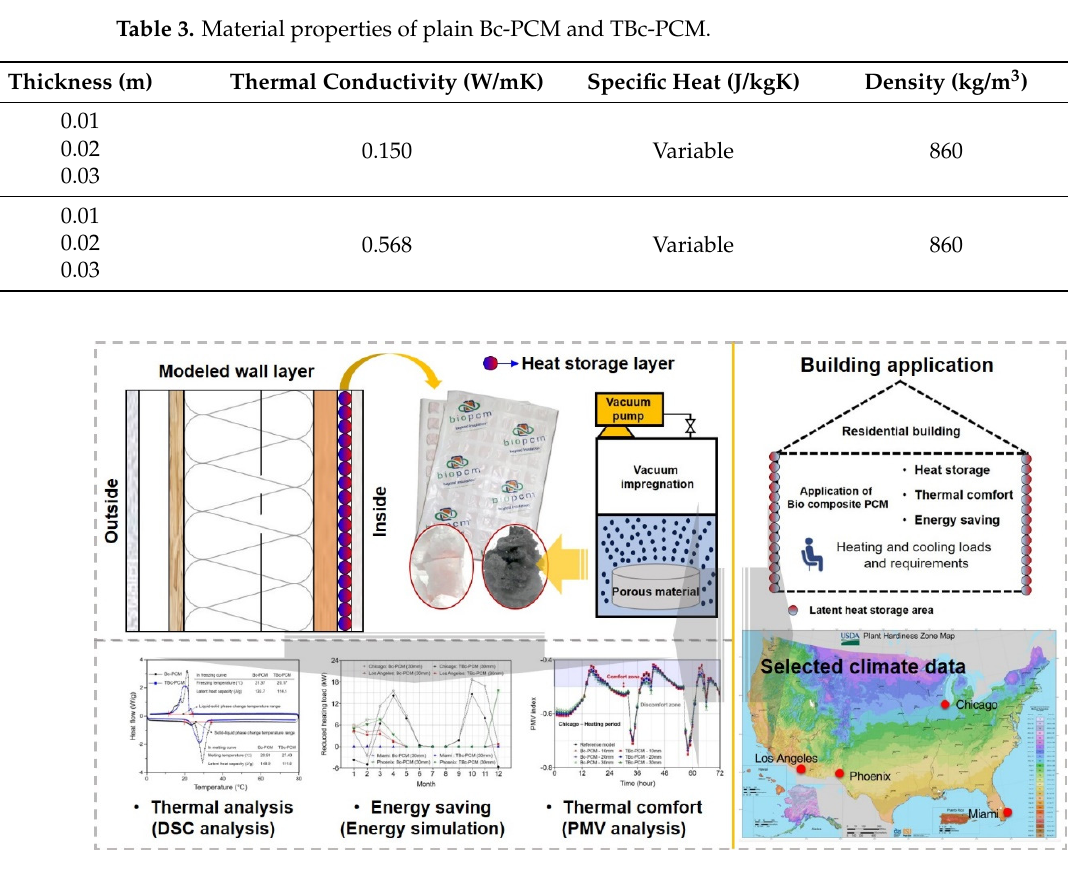
Figure 1. Schematic diagram of the research.